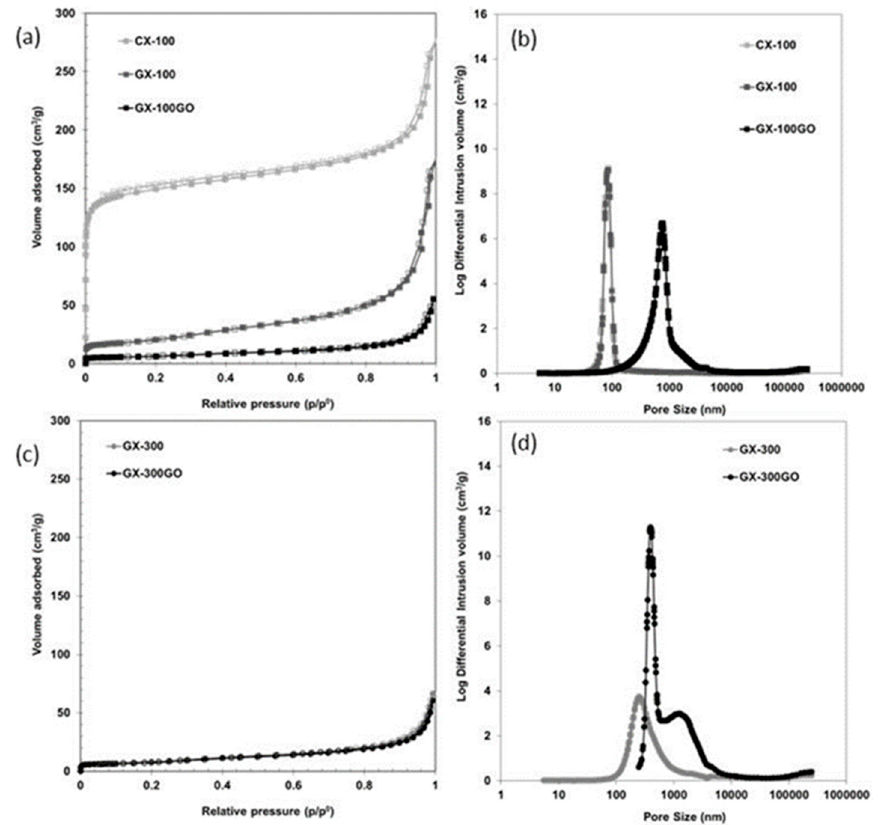
Figure 3. N 2 adsorption–desorption isotherms, ( a , c ), and pore size distributions obtained from mercury porosimetry, ( b , d ), of the xerogels analyzed.